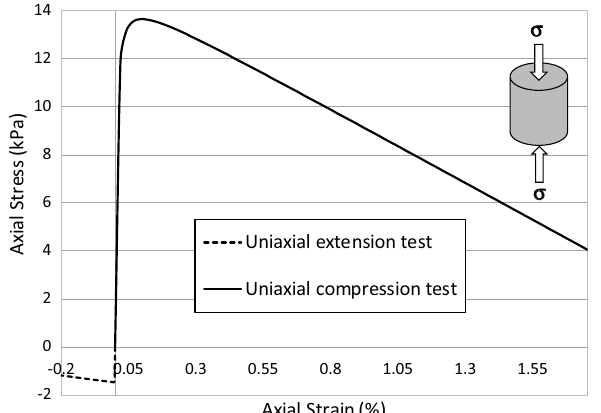
Fig. 5 Illustration of the linear elastic region and initial Young’s modulus—data from Kosar